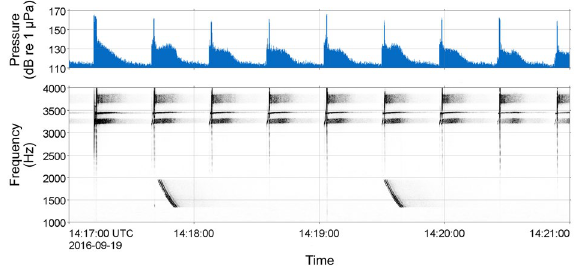
Figure 4. Timeseries (above) and spectrogram (below) displaying a sequence of sonar signals recorded over a 4-min period on September 19th 2016 at Station 5.